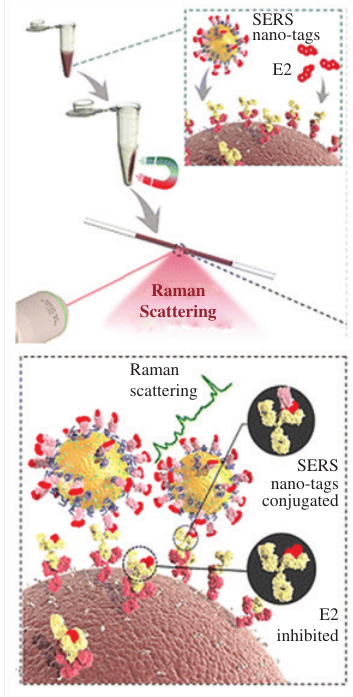
Figure 6: Schematic illustration of the SERS-based competitive immunoassay for quantification of E2- target where E2 and E2-con- jugated SERS nanotags competitively react with anti-E2 antibody on magnetic beads. Reprinted with permission from [87]. Copyright 2016 American Chemical